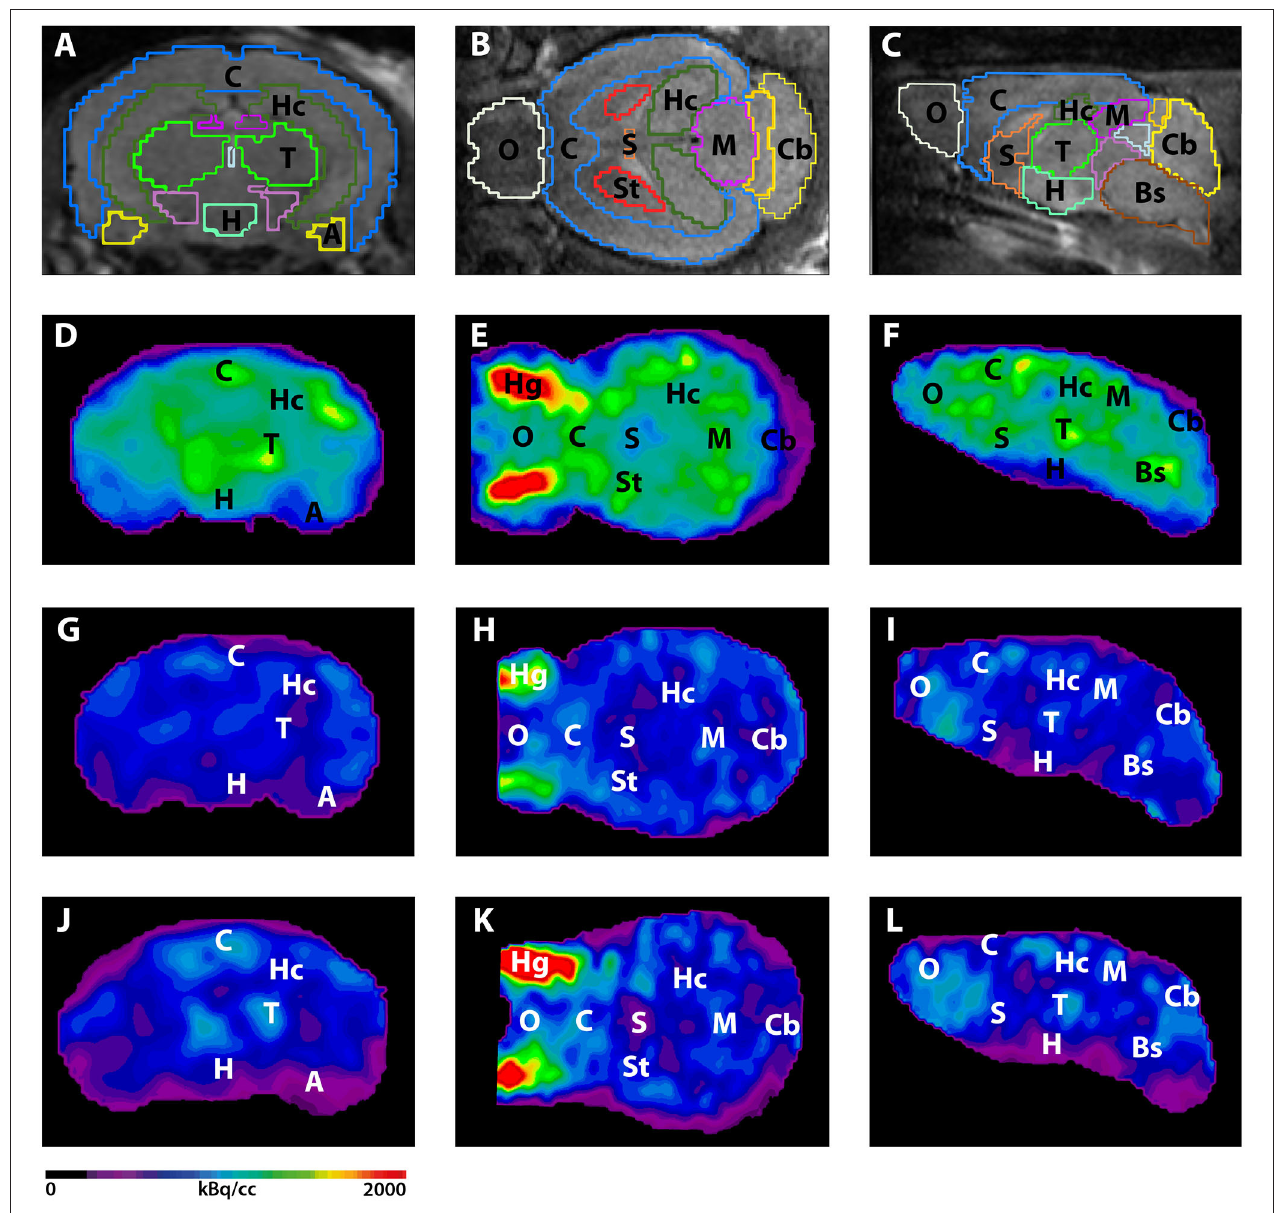
FIGURE 2 | 18 F-FDG-PET images in coronal, transverse, and sagittal view. (A–C) MRI images with predefined brain regions. (D–F) 18 F-FDG images of a representative 7-month-old WT mouse. (G–I) 18 F-FDG-PET images of a 7-month-old 5XFAD mouse. 7-month-old 5XFAD mice showed distinctly lower FDG uptake compared to WT mice. (J–L) 18 F-FDG images of a 12-month-old WT mouse. 12-month-old 5XFAD mice also showed significantly lower 18 F-FDG uptake compared to age-matched WT mice. A, Amygdala; Bs, Brain Stem; C, Cortex; Cb, Cerebellum, H, Hypothalamus; Hc, Hippocampus; Hg, Harderian Glands; M, Midbrain; O, Olfactory Bulb; S, Septum/Basal Forebrain; St, Striatum; T,